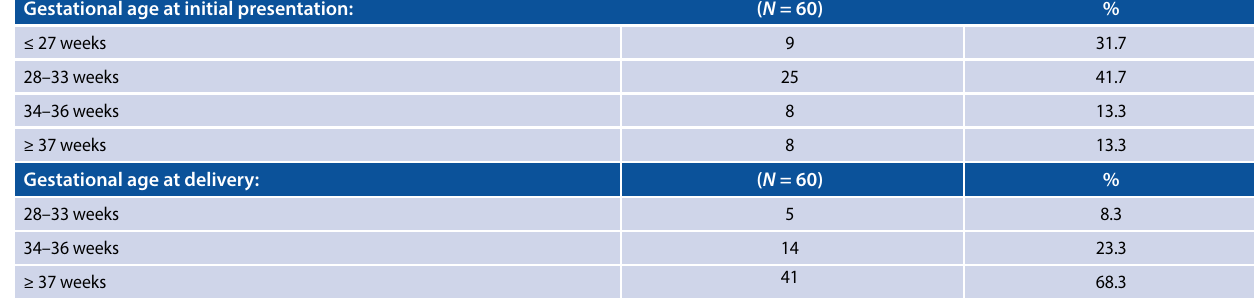
Table 3: Gestational age at presentation and delivery Gestational age at initial